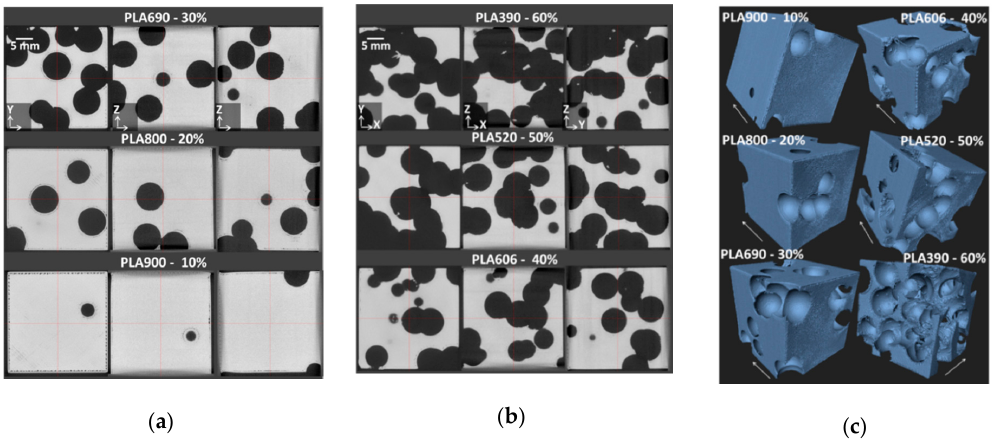
Figure 5. Cross-section views in the planes XY, XZ, and YZ from X-ray micro-tomography 3D images showing the cellular structure of 3D printed cellular PLA. ( a ) low porosity range 10–30%, and ( b ) large porosity range 40–60%, ( c ) Perspective views of 3D printed PLA cellular structures showing process-induced defects. The arrows indicate the building direction.